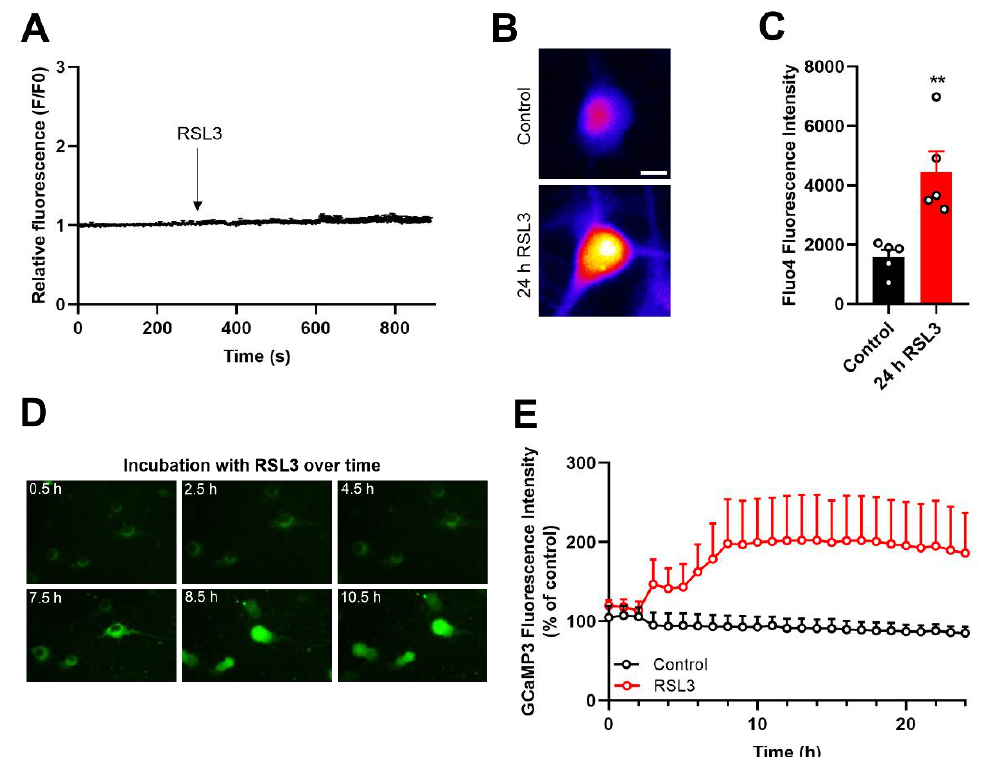
Figure 4. RSL3 treatment induces cytoplasmic Ca 2+ increases over time. ( A ). Representative time course of Fluo4 fluorescence changes before and after the addition of 15 µ M RSL3 to primary hippocampal cultures. Similar findings were obtained in N = 3 independent hippocampal cultures. ( B , C ). Primary hippocampal neurons treated with DMSO (control) or 15 µ M RSL3 (24 h) were loaded with Fluo4, and basal fluorescence was recorded. ( B ). Representative images of DMSO (control) and RSL3 treated neurons. Scale bar 10 µ m. ( C ). Quantification of the basal Fluo4 fluorescence displayed by N = 5 independent hippocampal cultures after 24 h incubation with 15 µ M RSL3 or DMSO (control). Statistically significant differences among experimental conditions were evaluated by paired t test. ** p < 0.0021. ( D ). Representative images of primary hippocampal cultures infected with rAAV-GCaMP3-NES. Images were acquired with the IncuCyte S3 live-cell imaging apparatus (Sartorius) using a 20 × objective. ( E ). Primary hippocampal cultures infected with rAAV-GCaMP3- NES showed time-dependent cytoplasmic [Ca 2+ ] increases in RSL3 treated hippocampal cultures. Primary hippocampal cultures from P1 pups were used in these